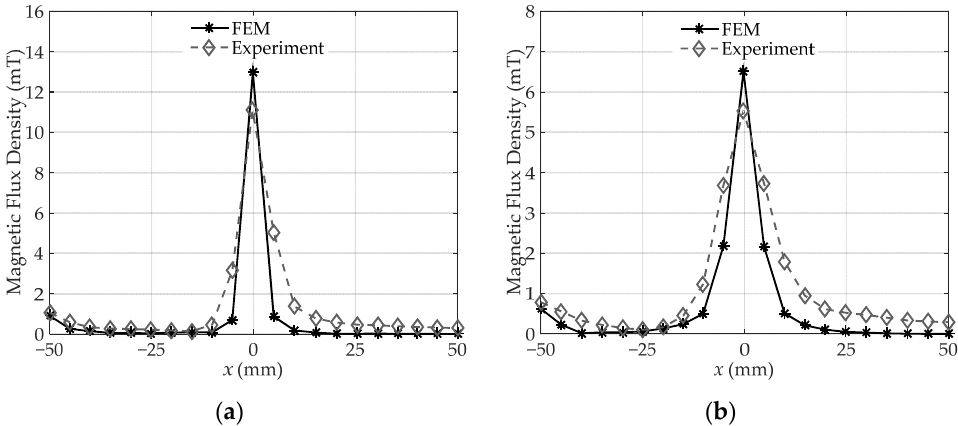
Figure 6. The leakage magnetic flux density ( a ) on the yoke surface center line; ( b ) 2 mm off the line. For the region 5 mm away from the air gap, the magnetic field plunges to less than 1 mT, which indicates that the magnetic flux density changes drastically around the gap.